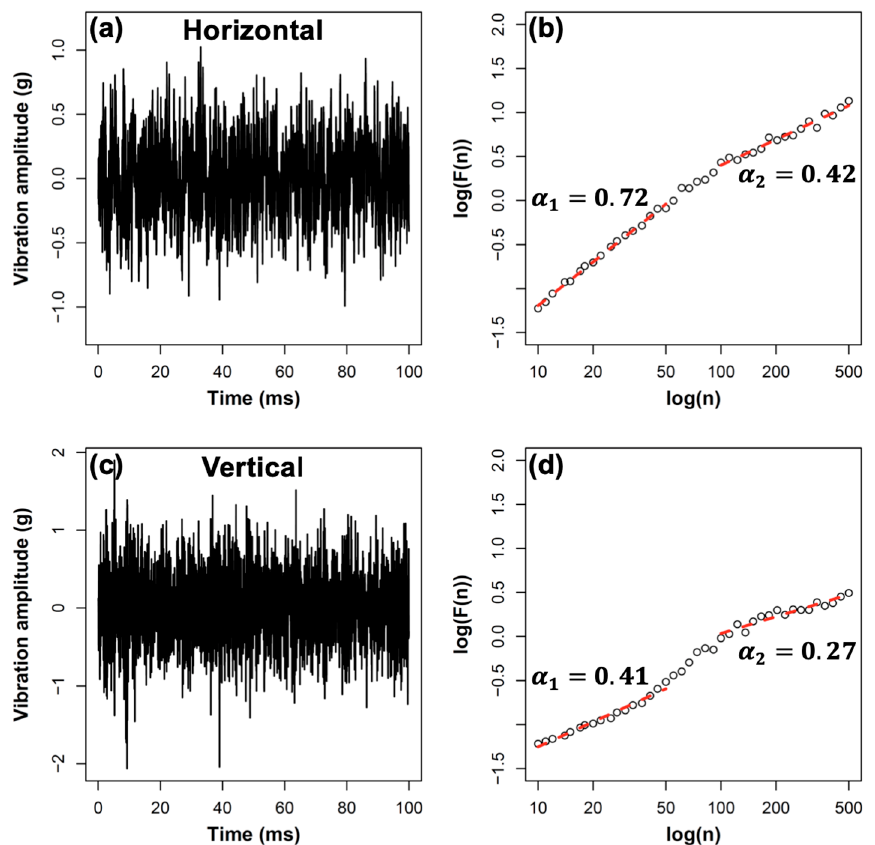
Figure 5. The 2560-sample bearing vibration signals (data set 1_1) and their corresponding fluctuation functions: ( a ) the bearing vibration signal (2560 samples or 100 ms) on the horizontal axis; ( b ) the fluctuation function ( F ( n ) ) vs. the box size (n) for the vibration signal on the horizontal axis; ( c ) the bearing vibration signal (2560 samples or 100 ms) on the vertical axis; ( d ) the fluctuation Figure 6. smaller time series consisting of 500 segments (5000 s) each, except the last one, which had 300 segments. Then, the scaling exponents ( α 1 and α 2 ) were estimated for each segment inside these series. The average fluctuation functions inside each of these 6 smaller time series are shown in Figures 6b and 7b. In both figures, the results show a persistent increase in the average scaling exponents ( α 1 ) at the short range by moving from the first time series (pink) to the last one (green). Although the average scaling exponents ( α 2 ) show a decreasing trend, it will be shown later that the scaling exponent ( α 2 ) behaves di ff erently in other data sets. For the horizontal and vertical vibration signals, the means and standard deviations of the scaling exponents ( (cid:2009) (cid:2869) and (cid:2009) (cid:2870) ) are shown in Table 3. In the horizontal vibration signal, the average scaling exponent ( (cid:2009) (cid:2869) ) changed from 0.43 (anticorrelated) at the beginning of the experiment to 0.98 (long-range correlated) before the bearing failure. The change in the scaling exponent ( (cid:2009) (cid:2869) ) at the short range could be related to a shift in the mechanical system dynamics as part of the run-to-failure experiment. Similarly, in the vertical vibration signal, the average scaling exponent ( (cid:2009) (cid:2869) ) had a gradual increase with time, starting from 0.18 in the first time series and increasing up to 0.47 in the last time